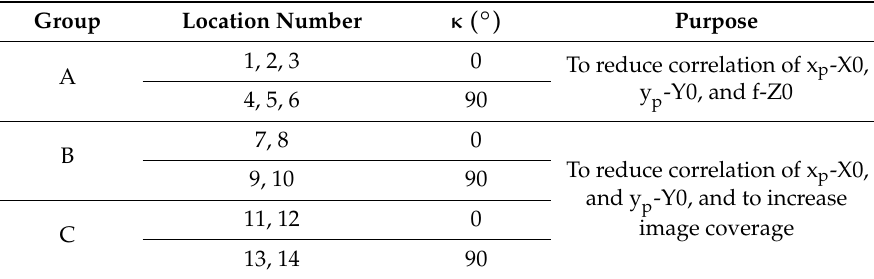
Table 15. Explanation of image groups shown in Figure 8.